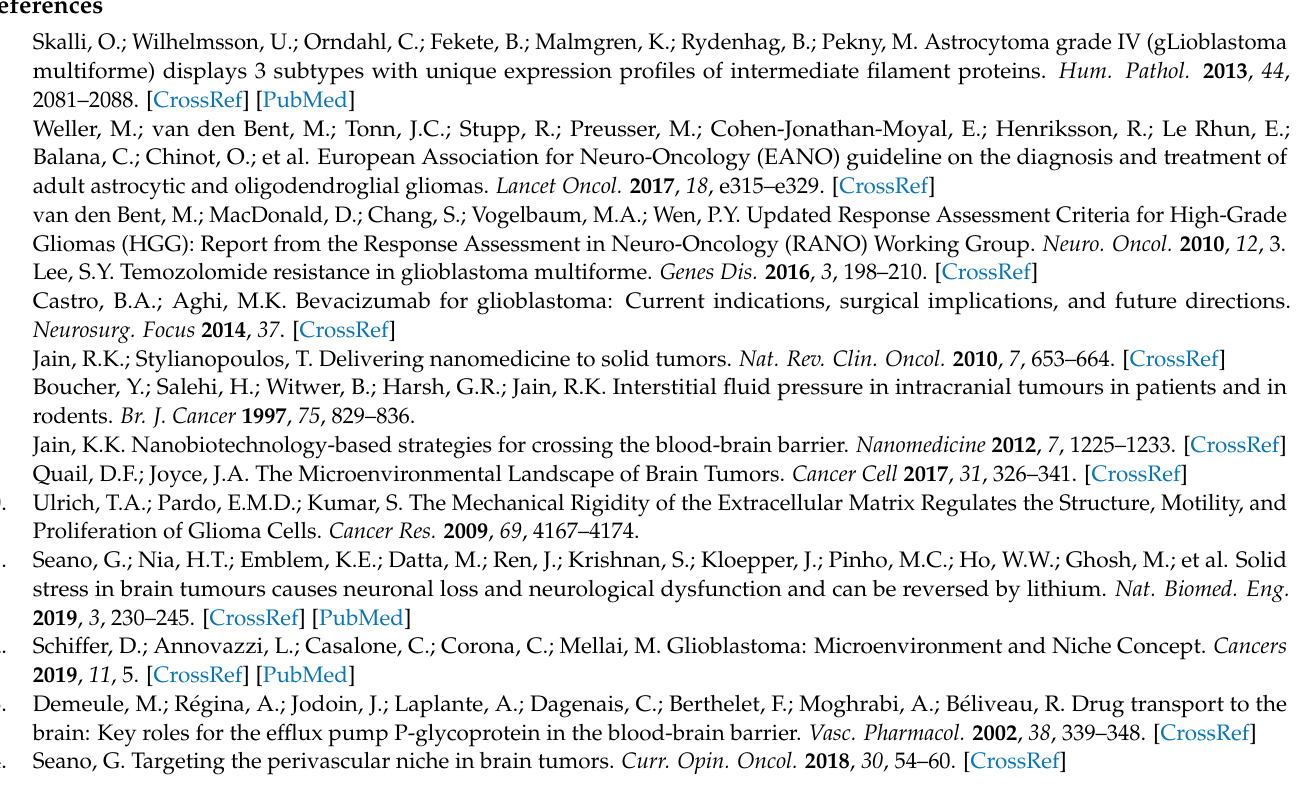
in water, Table S3: T1 measurement of NPs, Figure S7: Stability of cHANPs in culture medium at 37 ◦ C, Figure S8: Comparison of uptake rates by U87 cells of cHANPs and ANG-cHANPs in short times, Figure S9: MTT assay on U87-MG cells incubated with 10 µ M of free Irinotecan, Irinotecan in Thera-cHANPs and in Thera-ANG-cHANPs, Figure S10: BCA calibration curve, Figure S11: Calibration curves (a) ATTO 488; (b) ATTO 633, Figure S12: Raw flow cytometry data. Identification of cell population to estimate mean FSC/SSC values of (a) healthy untreated U87; (b) Thera-cHANPs treated U87; (c) Thera-ANG-cHANPs treated